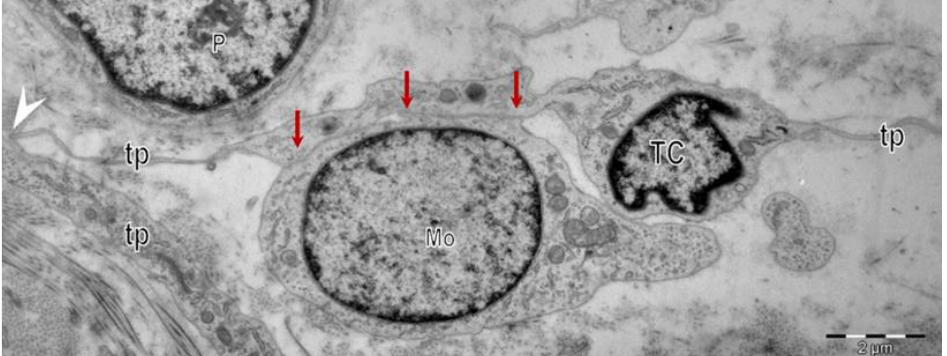
Figure 2. Electron microscopy images show telocytes (TCs) with telopodes (Tps) in a human skin biopsy. Heterocellular contacts (red arrows) are evident between telocytes (TCs) and the other cells in the interstitium. Homocellular junctions (arrowhead) connect the telopodes (Tps) of different telocytes (TCs) in a vast interstitial network.